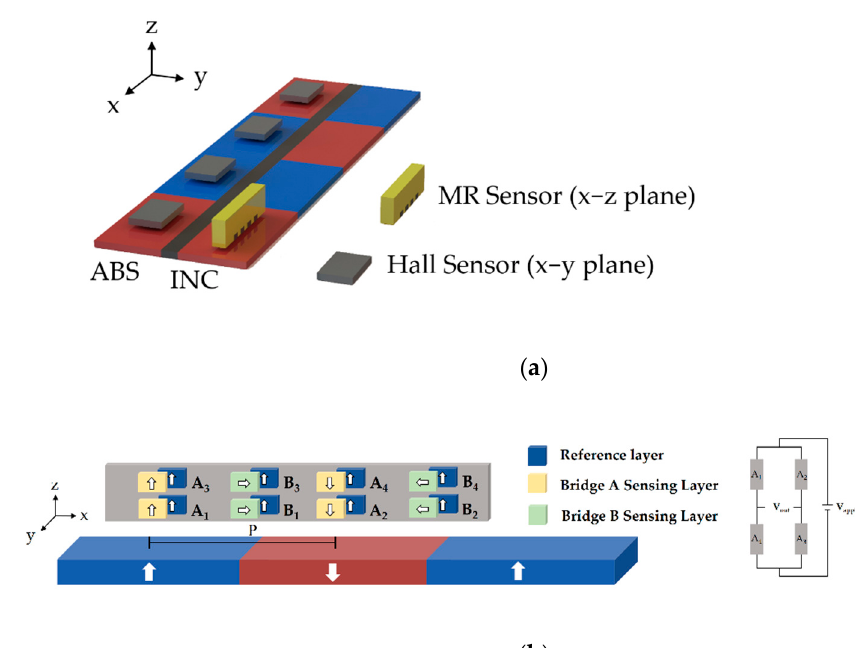
Figure 2. ( a ) The existing integrated system consisting of individual Hall and MR sensors. ( b ) The illustration for the magnetization directions of sensing layer (SL) and reference layer (RL) in the existing dual Wheatstone bridge TMR sensors for INC line placed in x–z plane. The schematic diagram for the Wheatstone bridge is also shown.